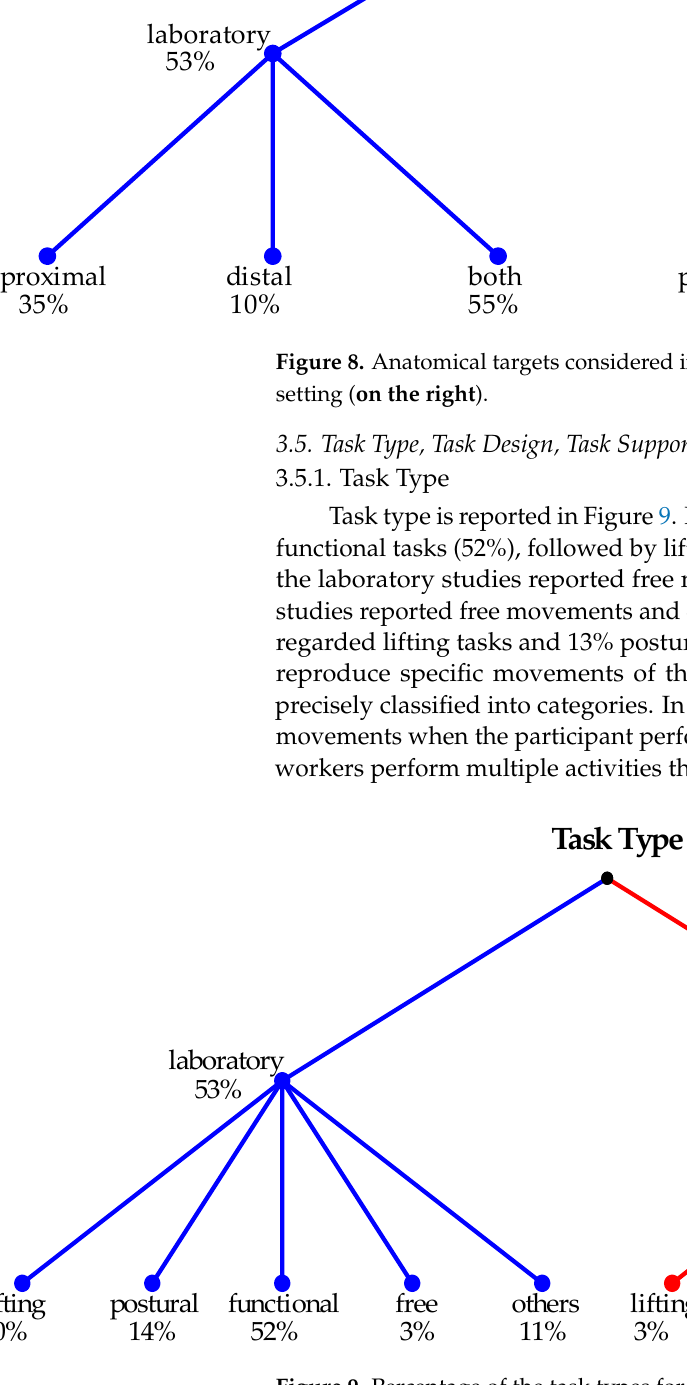
Figure 9. Percentage of the task types for the laboratory setting ( on the left ) and for the workplace setting ( on the right ).